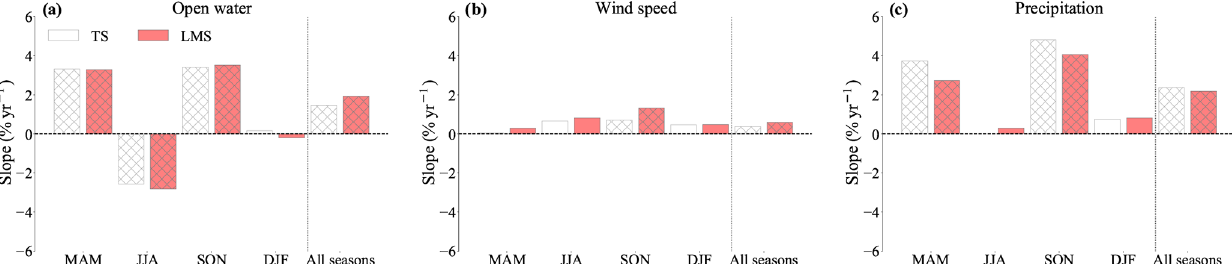
Figure 4. Relative trends in daily medians for (a) time spent above open water and within the ML, (b) median wind speed, and (c) accumu- lated precipitation along each back trajectory for different seasons and all seasons. The white bar displays the Theil–Sen estimator (TS). The red bar displays log-transformed least mean square (LMS) trends. Cross-hatching denotes trends that have statistical significance (ss) at a confidence interval of 95%. The ss for the TS is based on the “pre-whitened” (PW) time series. The dashed line aids the reader in separating the individual seasonal trends and the trend with all the seasons